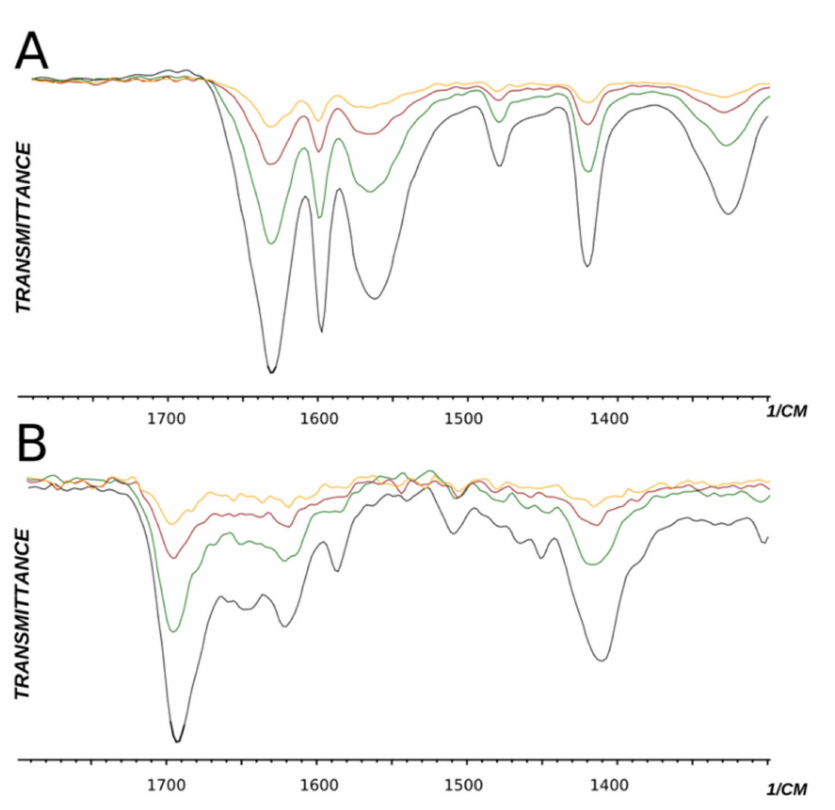
Figure 4. IR spectra of compounds 10 ( A ) and 11 ( B ) in different concentrations. Black—24%, green—12%, red—6%, yellow—3% mass in